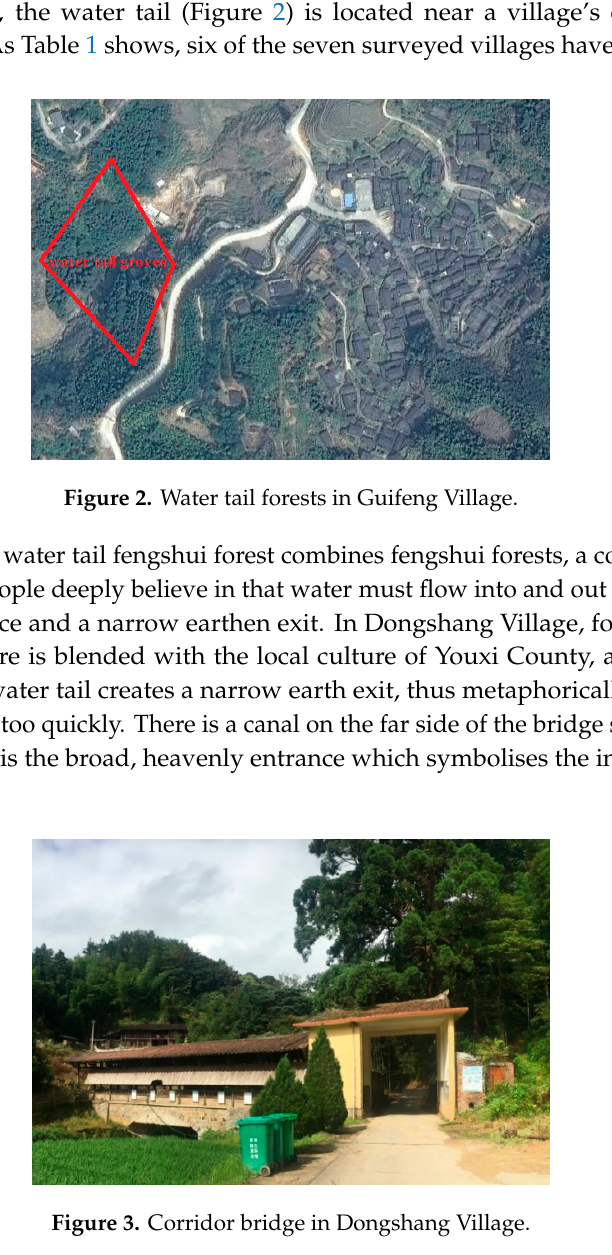
Figure 3. Corridor bridge in Dongshang Village.